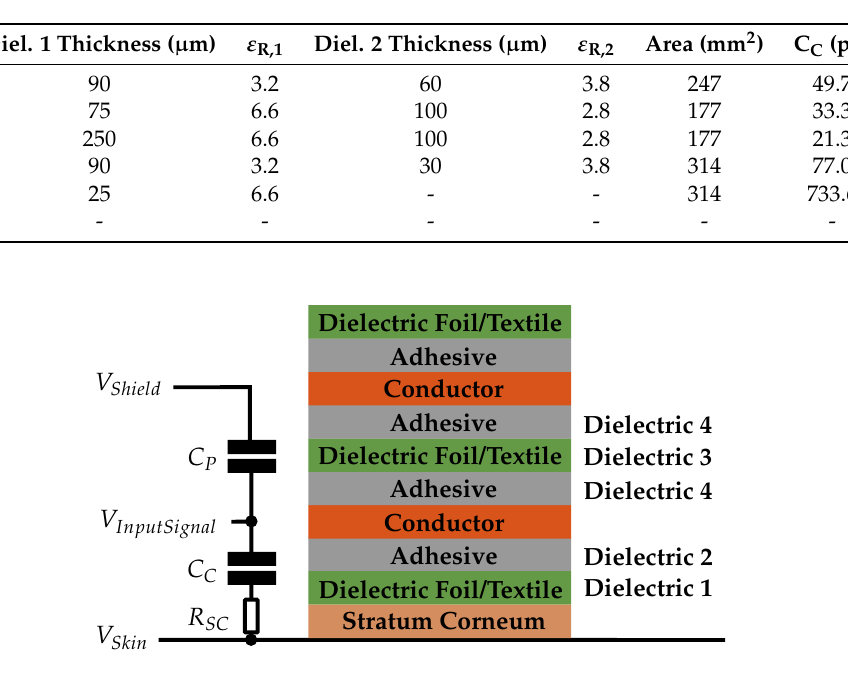
Table 2. Calculated coupling capacity C C of various sensor assemblies. Dielectric 1 is the dielectric foil or textile. Dielectric 2 is the silicone or acrylic adhesive.